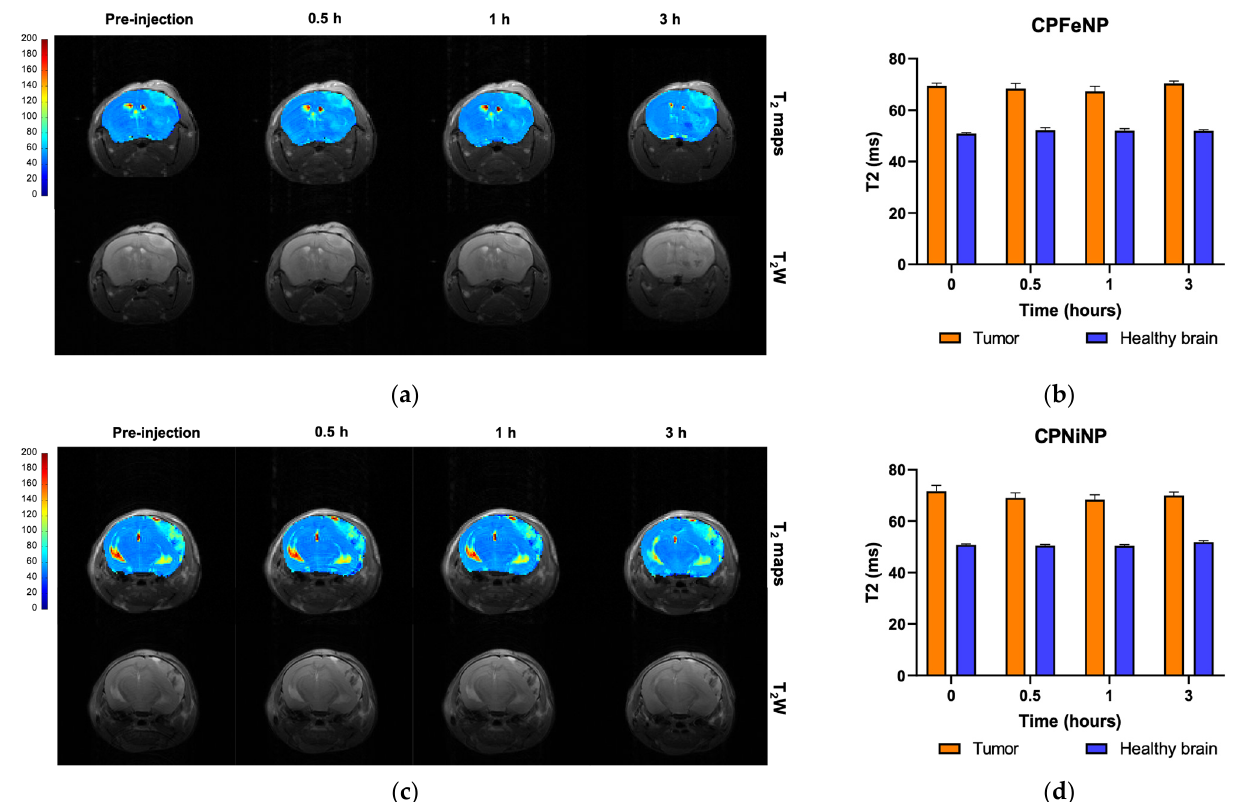
Figure 5. T 2 color-code based maps and T 2 W images of orthotopic GBM model. Data were acquired before the i.v. administration of the IONP-doped CPNs, and at 0.5, 1 and 3 h after the injection. MRI evaluation of CPFeNP ( a ) and CPNiNP ( c ). Graphical bar showing the variation in T 2 values (mean ± SEM) along the temporal evaluation of CPFeNP ( b ) and CPNiNP ( d ).